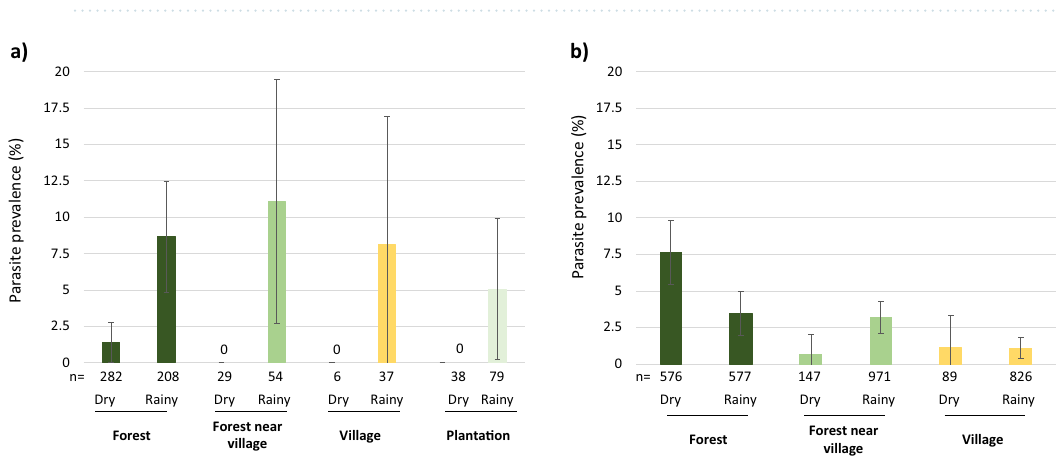
Figure 3. Day biting rate (proportion of Anopheles females collected between 6am and 6 pm) of mosquitoes captured in the different collection sites and seasons in ( a ) HBNTs and ( b ) CBNTs. The day biting rate was significantly higher during the dry season compared to the rainy season in both kind of traps (HBNTS χ 2 = 19.08, df = 1, p < 0.001 and CBNTS χ 2 = 115.53, df = 1, p < 0.0001). Data show average proportion ± 95% confidence intervals.